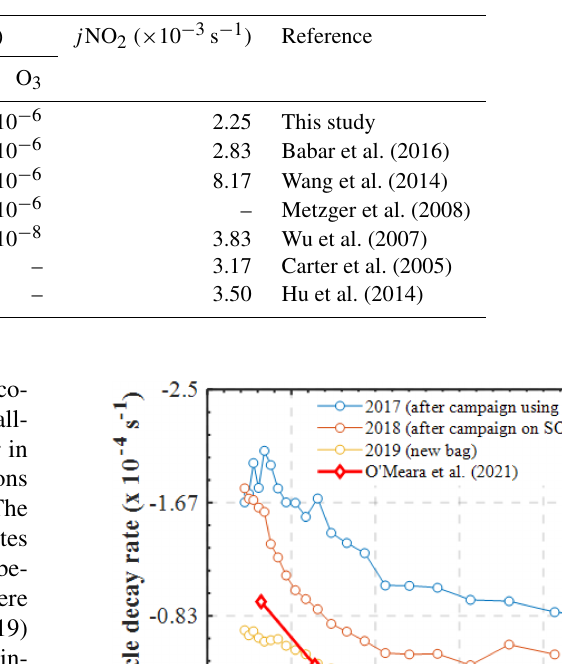
Table 2. NO 2 and O 3 wall loss rates as well as j NO 2 obtained in this study and the literature.